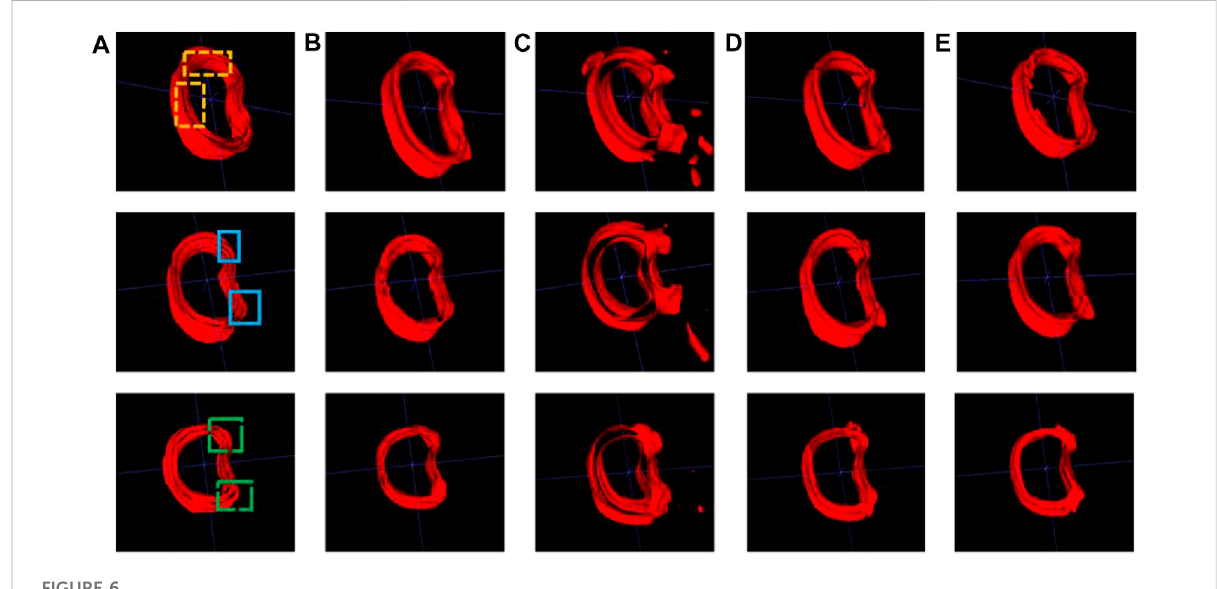
FIGURE 6 Cortical bone segmentation results (each row from left to right are the gold standard and segmentation results of the different algorithms). (A) Ground-truth; (B) 3D U-Net; (C) Ki U-Net; (D) Res U-Net; (E) Seg